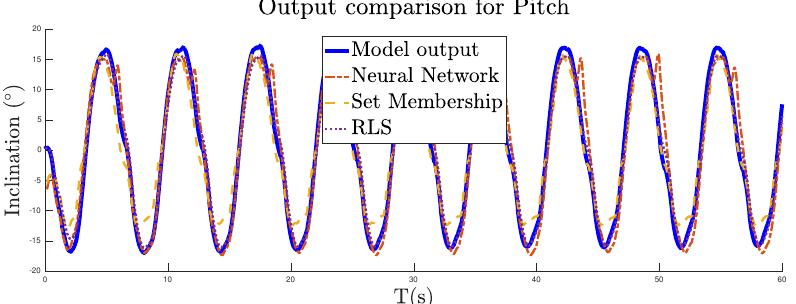
Figure 20. Prediction configuration results for pitch in Test 3.